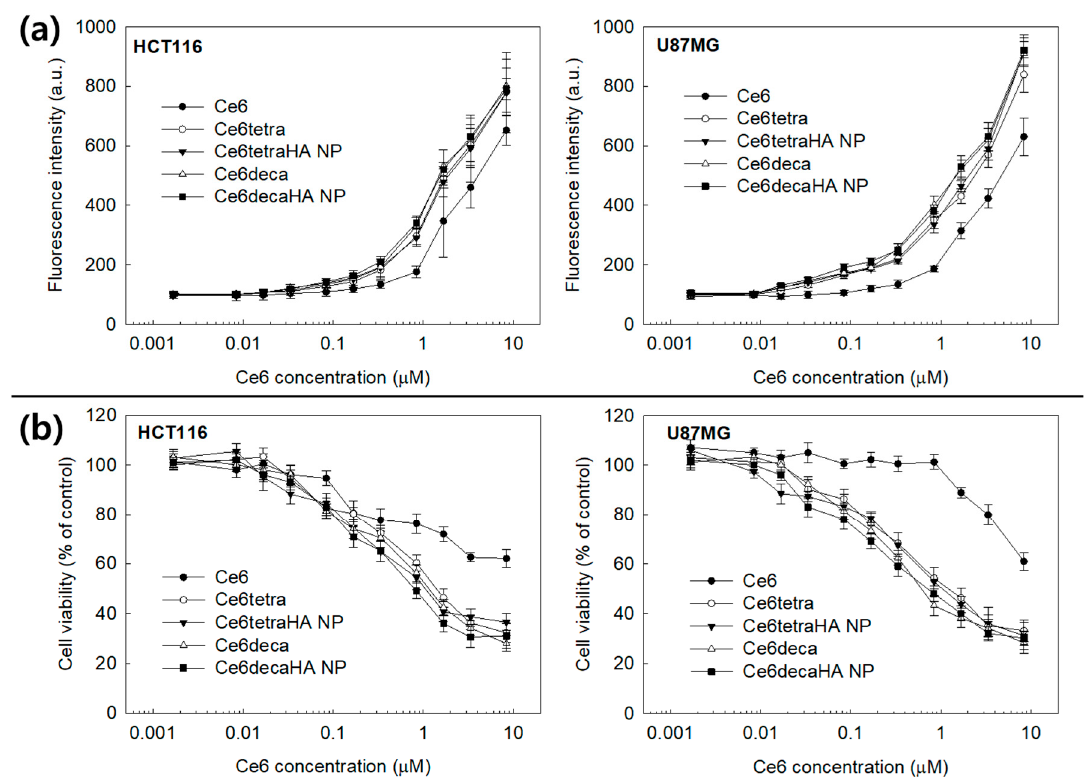
Figure 8. The effect of Ce6 or Ce6tetraHA and Ce6decaHA nanophotosensitizer treatment against cancer cells. Reactive oxygen species (ROS) generation ( a ) and hotodynamic therapy (PDT) treatment ( b ). Cells were irradiated at 664 nm (2 J/cm 2 ). All values are average ± S.D. from results of a single independent experiment with eight replicate.